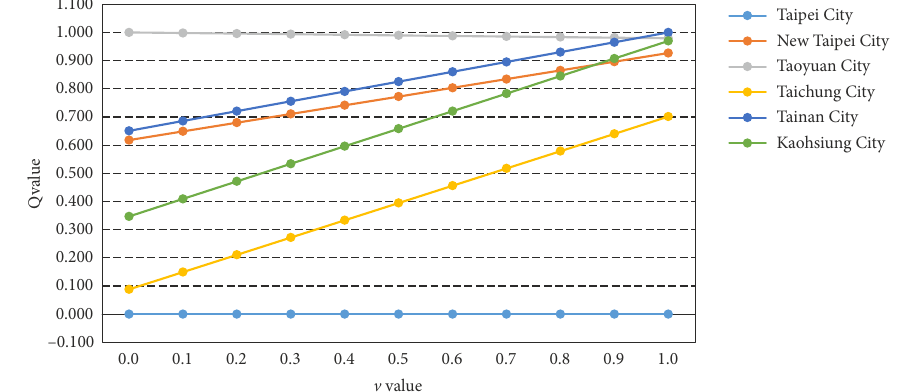
Figure 8. Simulation of the six cities for different v value in basic conditions